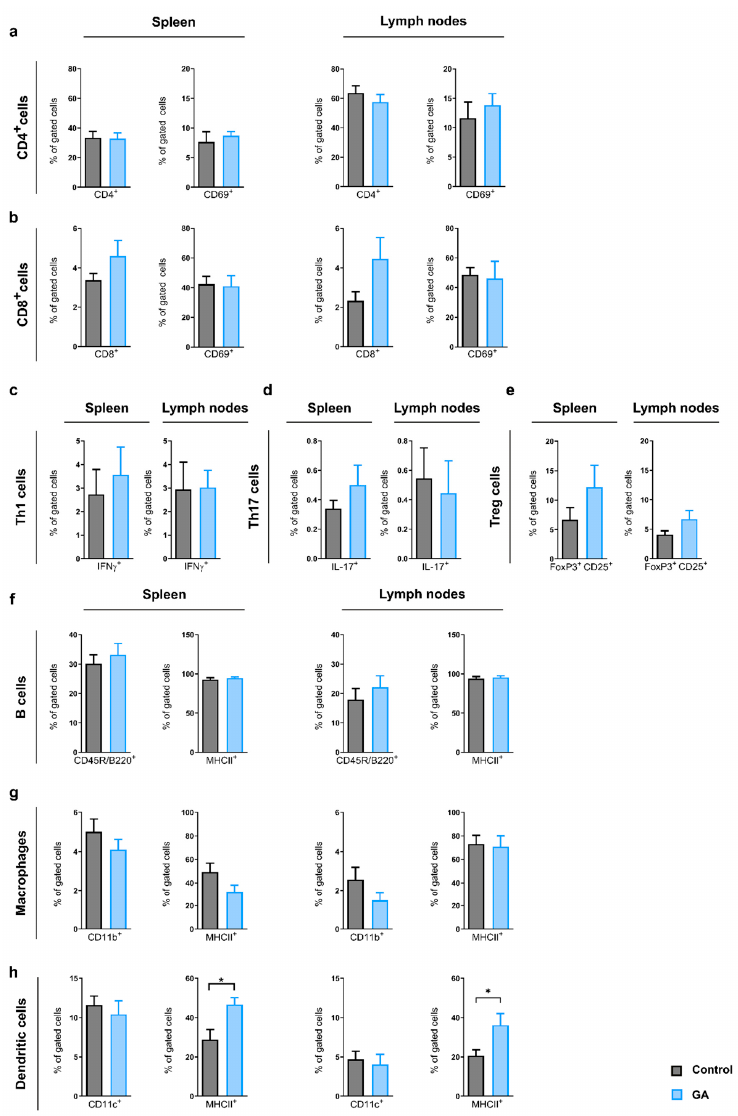
Figure 4. GA treatment enhances frequency of activated dendritic cells without effect on other immune cell subpopulations in secondary lymphoid organs. Frequencies of immune cells in secondary lymphoid organs were analyzed using flow cytometry. ( a ) Frequencies of CD4 + T helper ( a ) and CD8 + cytotoxic T cells ( b ), as well as activated forms (CD4 + CD69 + and CD8 + CD69 + ), did not differ between control and GA-treated mice. Th1 and Th17 subpopulations were unaffected ( c , d ), while regulatory T cells trended towards higher frequencies in GA-treated mice ( e ). In the spleen and the lymph nodes, frequencies for CD45R/B220 + B cells, as well as the activated form (CD45R/B220 + MHCII + ), were unaltered ( f ). In the spleen and the lymph nodes unactivated macrophages ( g ), as well as DC frequencies for both groups, revealed similar findings (h). While activated (CD11b + MHCII + ) macrophages ( g ) were unaffected, activated (CD11c + MHCII + ) DCs ( h ) were significantly increased in the GA-treated mice compared to the control group. Data are shown as mean ± SEM; * p < 0.05. (Spleen: control n = 11, GA n = 8; lymph nodes: control n = 11, GA n =